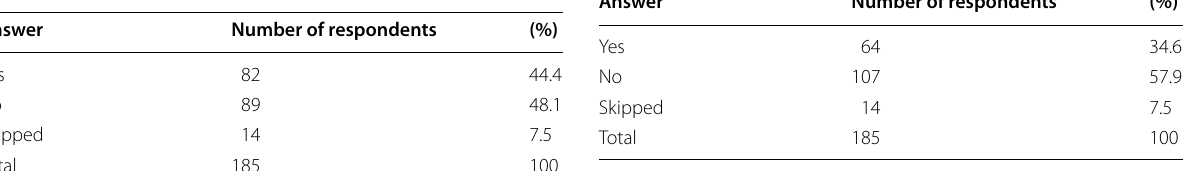
Table 6 Experience of 185 respondents with AI-based algorithms for clinical diagnostic interpretive tasks: Were discrepancies between the software and the radiologist recorded?